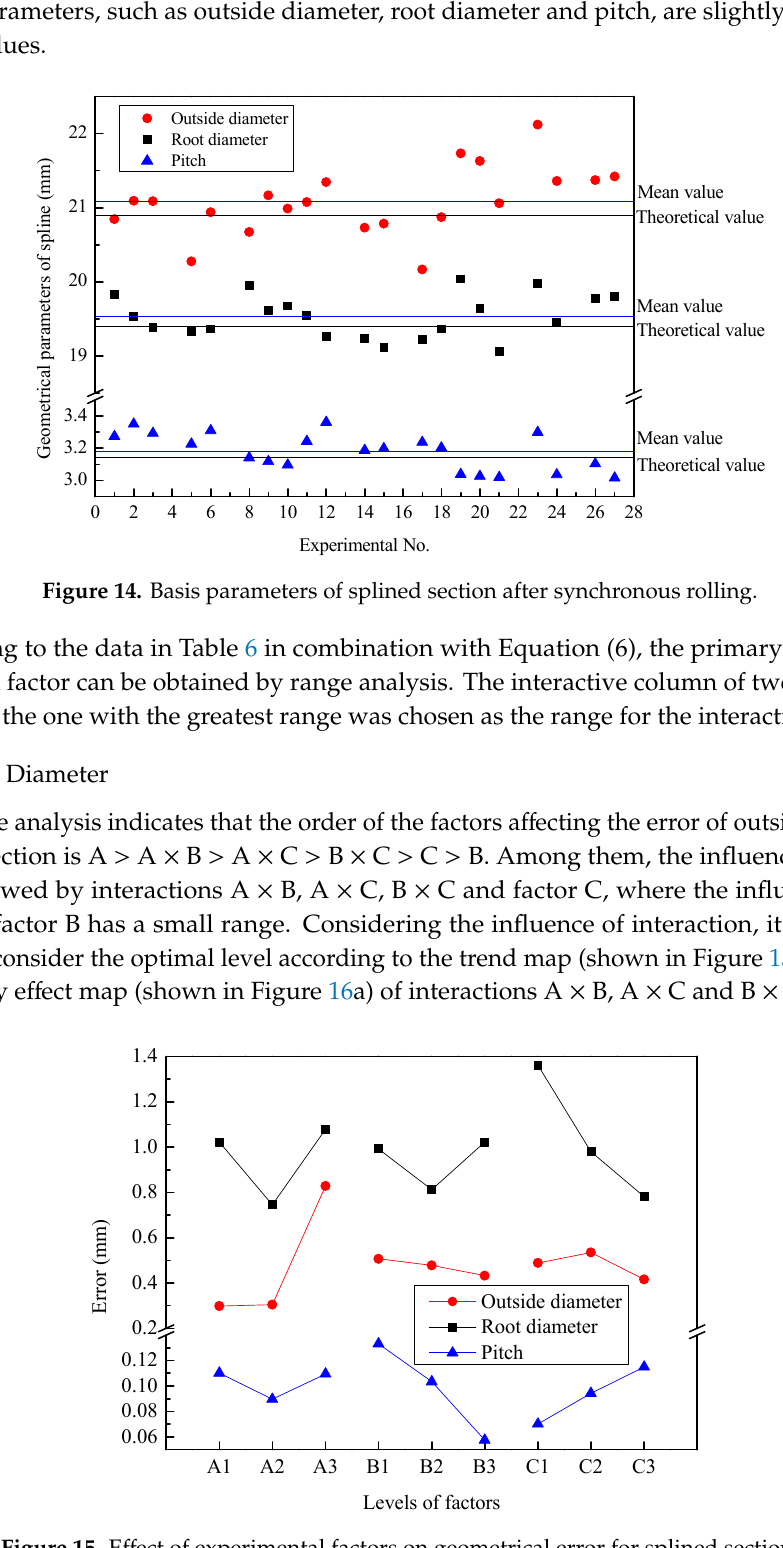
Figure 15. Effect of experimental factors on geometrical error for splined section. Figure 15. E ff ect of experimental factors on geometrical error for splined